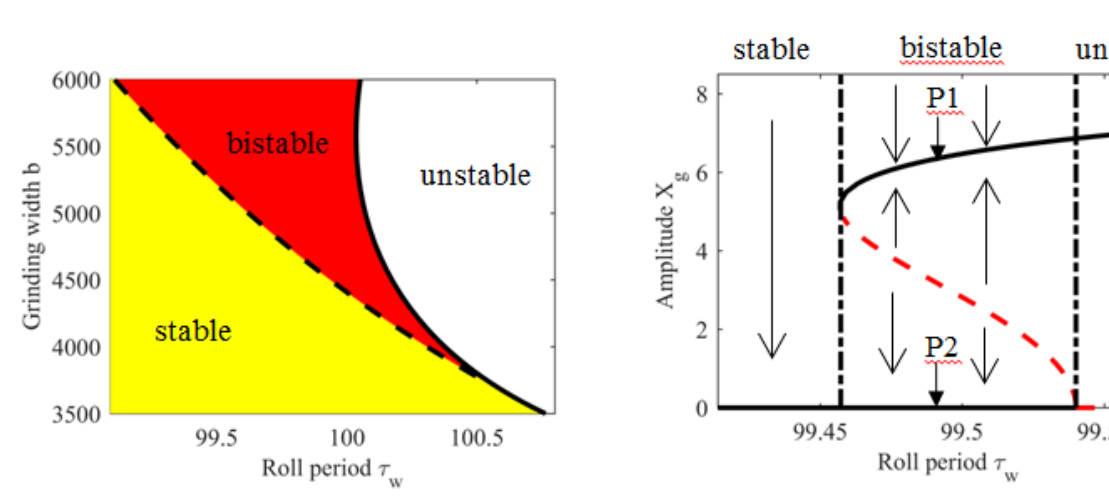
Fig. 6. Enlarged view for the region A in Fig. 3 Fig. 7. Subcritical Hopf bifurcation diagram with the stable, bistable and unstable